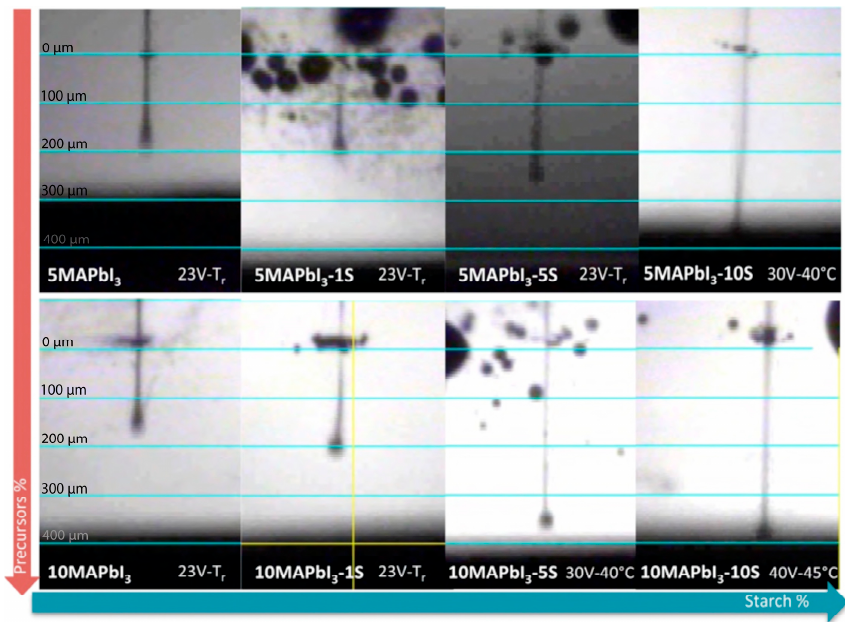
Figure 2. Droplets ejected from the nozzle for the different inks explored.